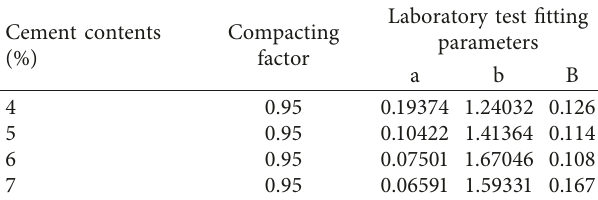
Table 2: Fitted model parameters of the improved CWG based